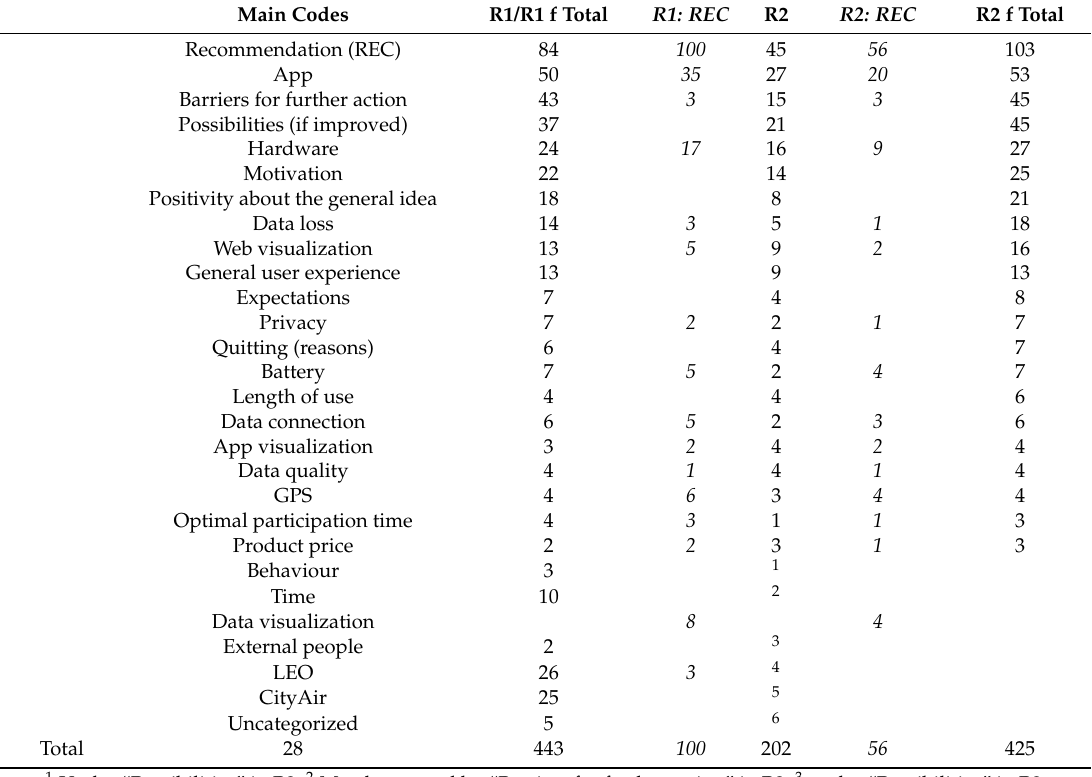
Table 2. Number and frequency of codes in each coding iteration (coding rounds R1 and